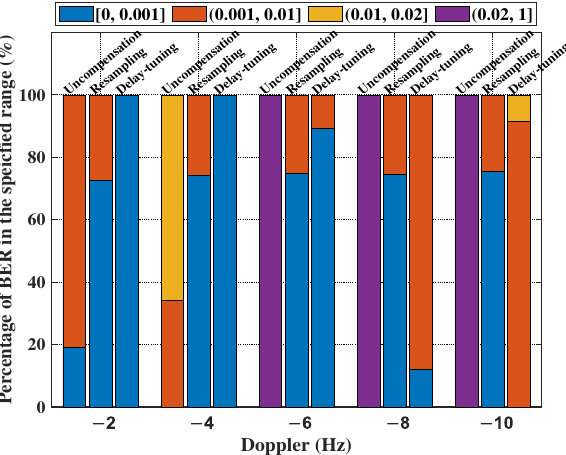
Figure 6. The BER outputs of different communication schemes under different Doppler